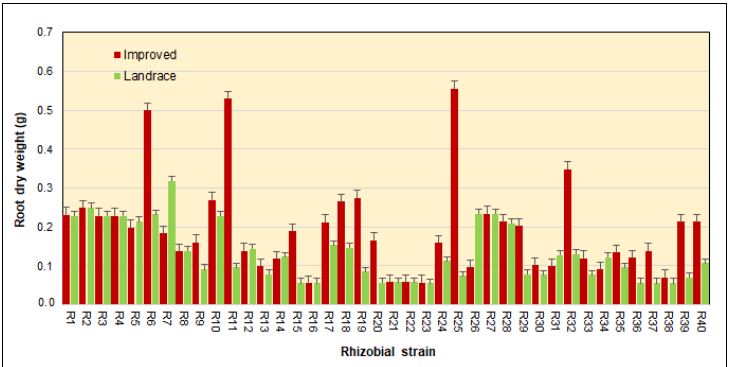
Figure 4. The effects of inoculation with rhizobial strains on the shoot dry weight per plant of the landrace and improved pigeonpea genotypes. The identity of each rhizobial strain (R1–R40) is described in Table 2 and the results of the statistical analysis are reported in Tables S1 and S2 (depending on the genotype).